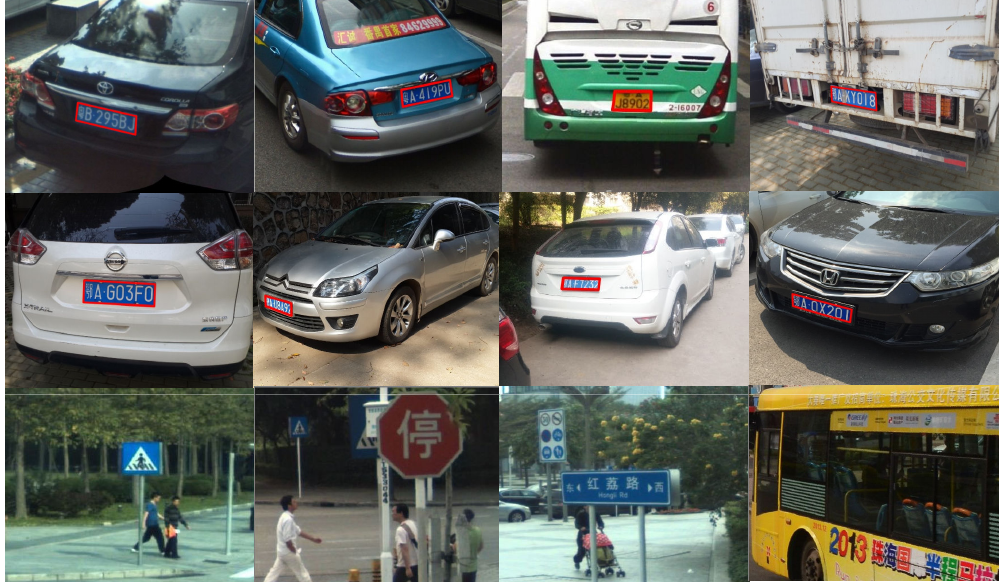
Figure 3. Sample images of our license plate dataset. First two rows: positive samples containing license plates with different orientations and multiple scales. All the license plates were manually labeled by the exact four edge points. Third row: negative samples containing objects similar to license